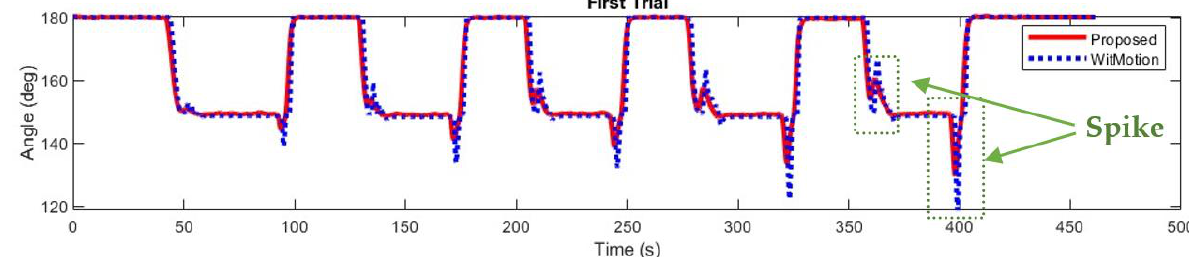
Figure 7. Measured angle using proposed algorithm (PA) and WitMotion (WM) (second trial).